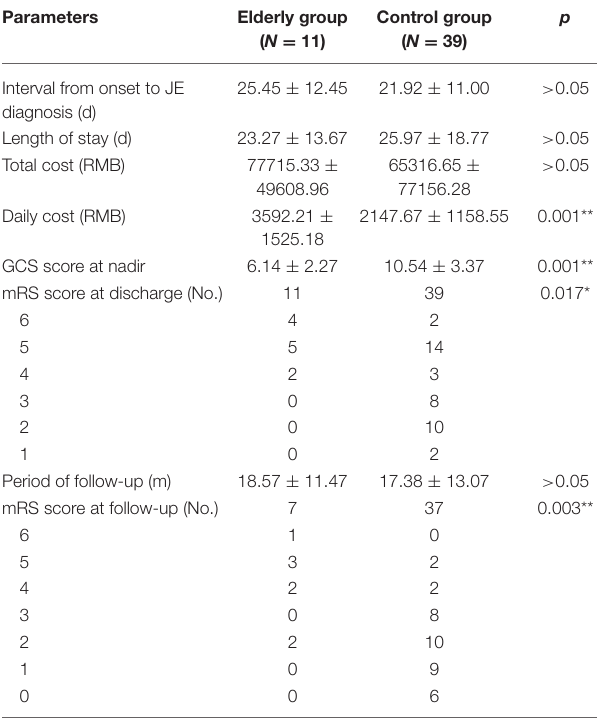
TABLE 3 | Outcomes of the two groups with JE.